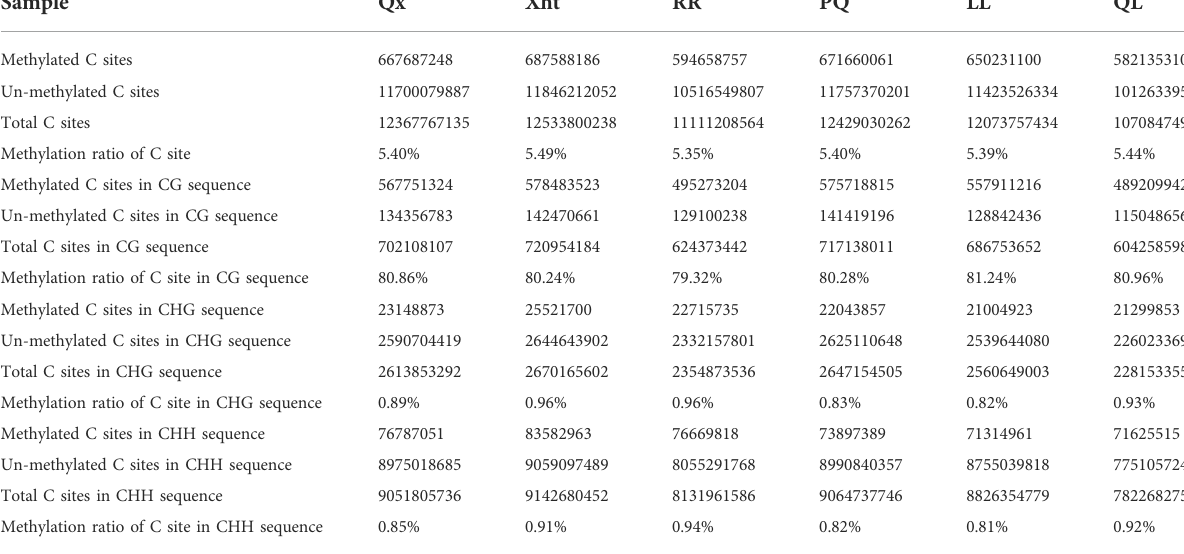
TABLE 2 Ratio statistics of genome cytosine